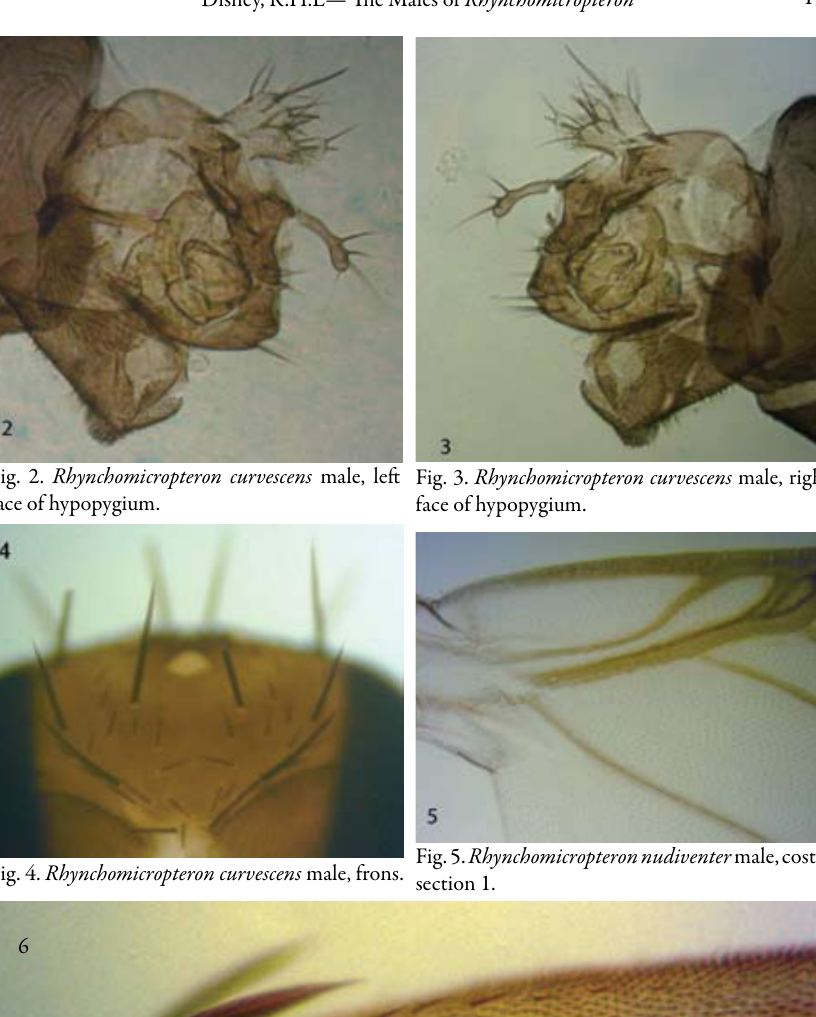
Fig. 4. Rhynchomicropteron curvescens male, frons.